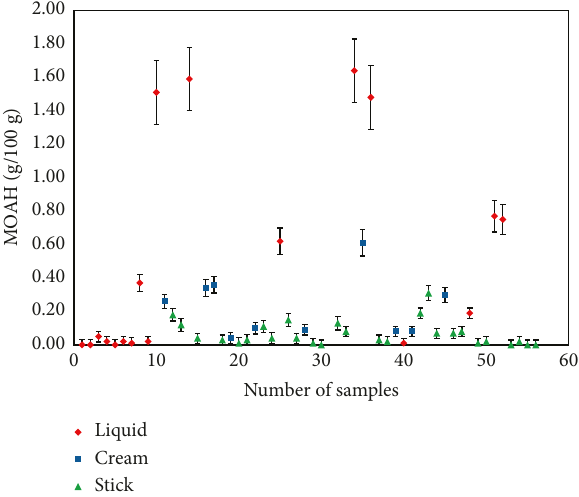
Figure 11: MOAH content in g/100 g sample for a selection of retail lip products. Classification according to the consistency (red–liquid; blue–creamy; green–solid).